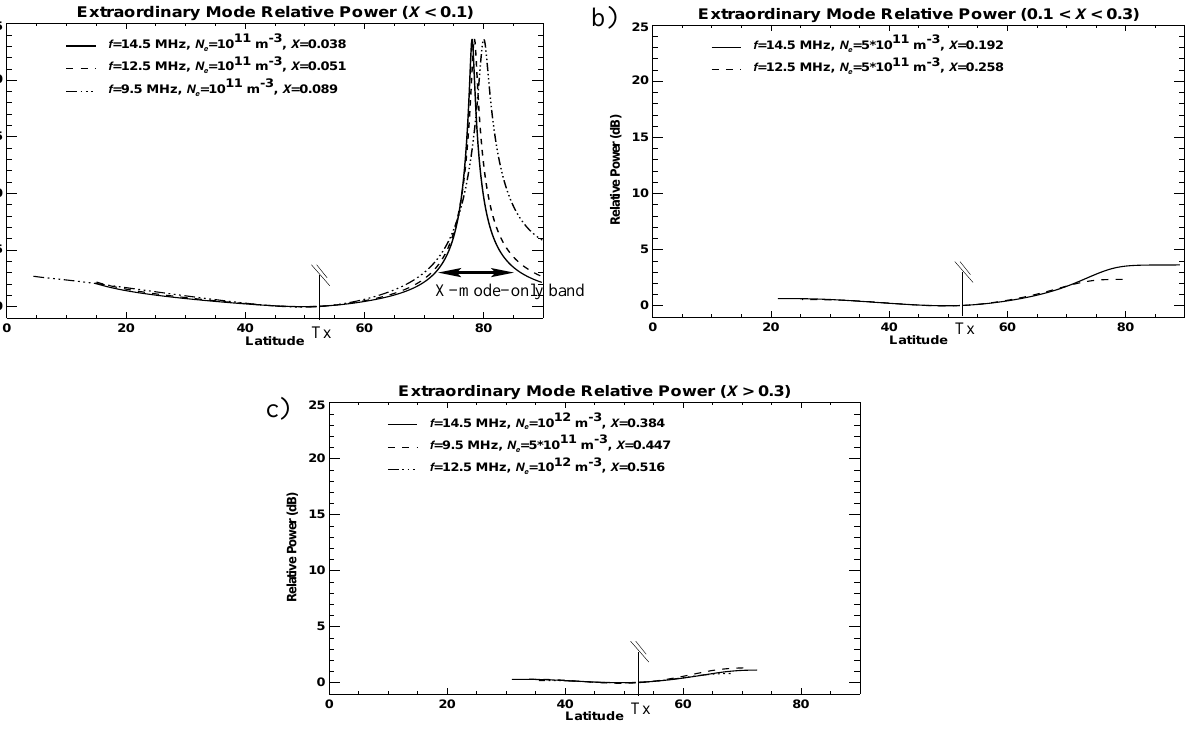
Fig. 7. Modelled X-mode relative power that will be received by the RRI on ePOP. Panels (a) , (b) , and (c) illustrate transmitter frequency and ionospheric peak density combinations which correspond to; X < 0 . 1, 0 . 1 <X < 0 . 3, and 0 . 3 <X , respectively. The modelling assumes a north-south satellite orbit at 1500km directly over the Saskatoon SuperDARN radar (latitude – 52.16 ◦